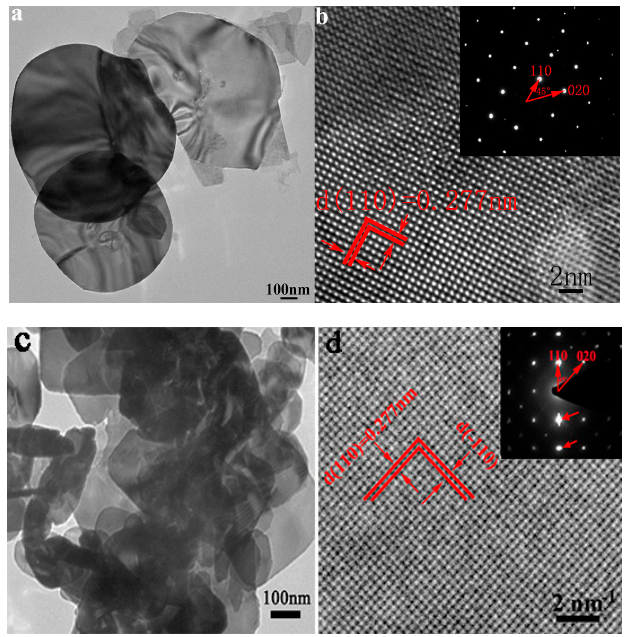
Figure 3. TEM ( a , c ) and high-resolution TEM (HRTEM) ( b , d ) images of the obtained samples. BiOBr ( a , b ); BiOBr-Ov ( c , d ).